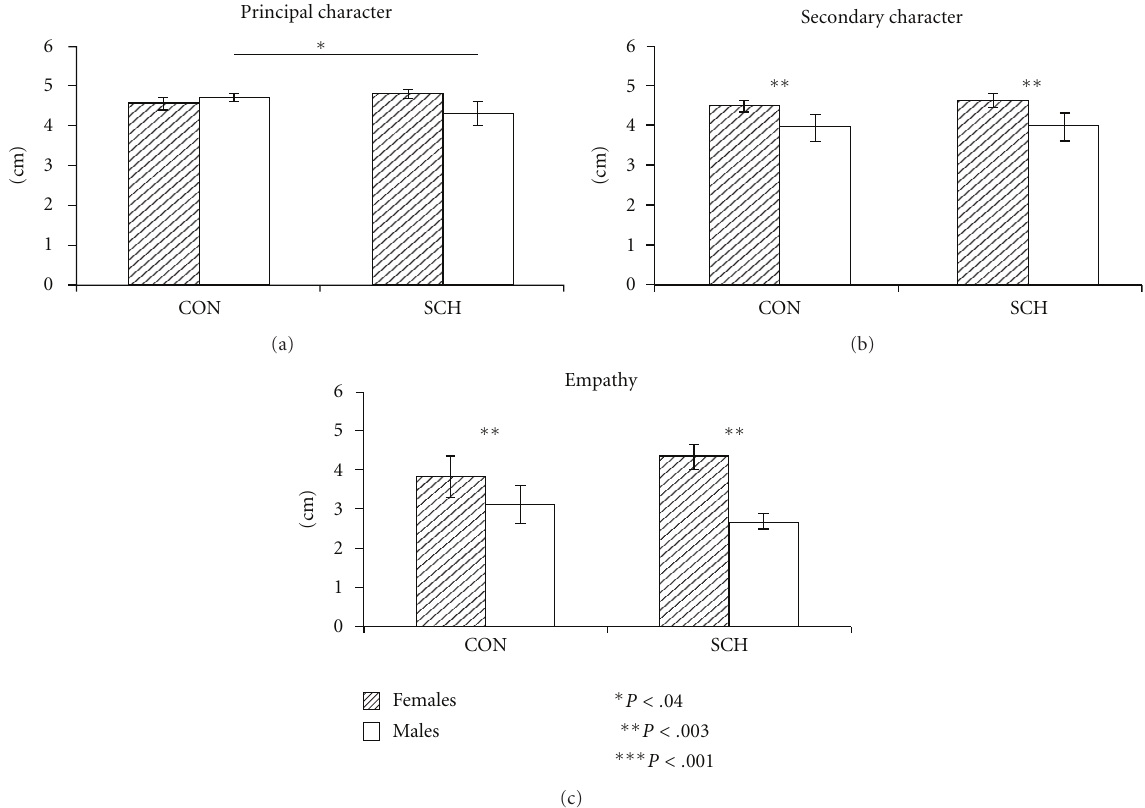
Figure 4: Means and standard errors for intensity level attributed to happiness expression from the principal and second characters and the empathy level experienced during the happiness film for females and males of the control (CON) and schizophrenic groups